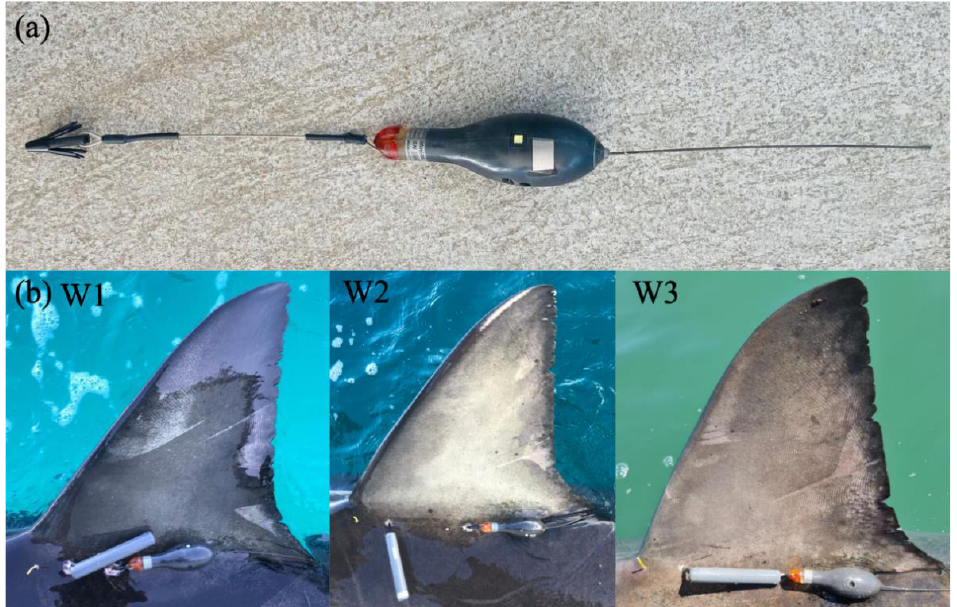
Figure 2. ( a ) MiniPAT-348 Pop-up Satellite Archival Transmitting Tag and Domeier dart head used to anchor the MiniPAT tags and acoustic transmitters into the sharks musculature, and ( b ) dorsal fins of the three white sharks used in the present study. Images taken after completing tagging procedure, with MiniPAT tags, acoustic transmitters and conventional tags visible (images provided by the New South Wales Department of Primary Industries).